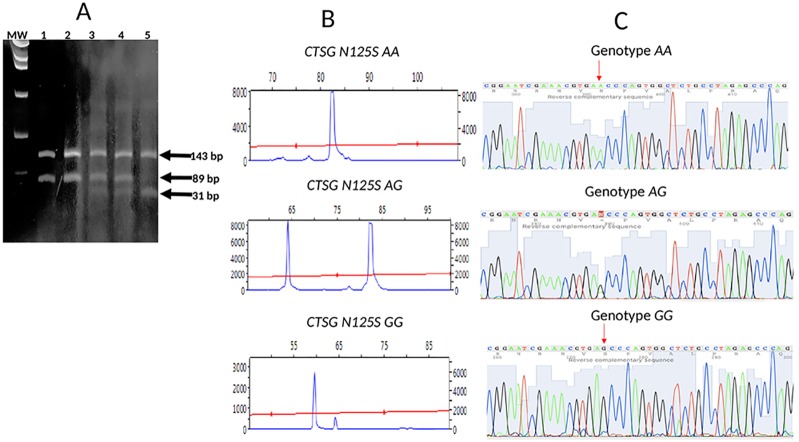
Detection of the N125S (rs 45567233) polymorphism in the CTSG gene.(A): polyacrylamide gel analysis of genomic DNA from 5 patients with acute osteomyelitis (OM) processed as in methods. AA denotes a wild-type sample with two distinct bands of 143 and 89 bp (lanes 1 and 2); AG denotes a heterozygous sample showing three distinct bands of 143, 89 and 31 bp (lanes 3 and 4); GG denotes a double variant sample showing two distinct bands of 143 and 31 bp (lane 5). MW, molecular weight markers; (B) Peak scan analysis of 3 patients with the genotypes AA, AG and GG; (C) Sequencing of the restriction fragment length polymorphism. Samples with no alteration: wild type (upper); with a heterozygous A-to-G replacement (middle) and with a double A-to-G replacement (lower).